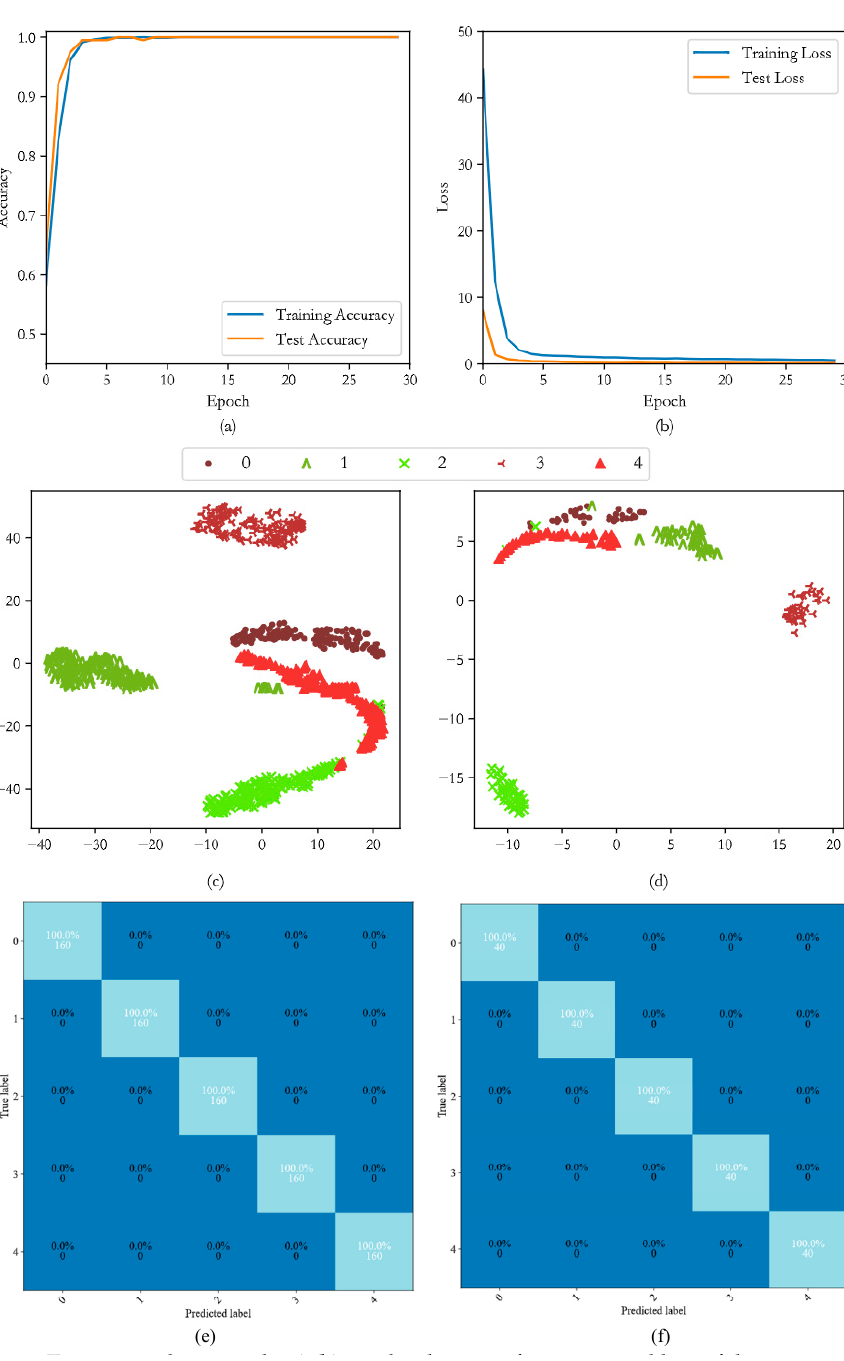
Figure 13. Training and test results. ( a , b ) are the changes of accuracy and loss of the training and testing datasets with epoch, ( c , d ) are the visualization results of the training and testing results by t-SNE, ( e , f ) are the confusion matrix of the training and test results